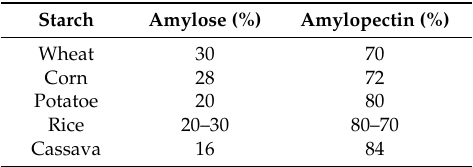
Figure 4. Amylose ( a ) and amylopectin ( b ) structures. Table 2. Amylose and amylopectin contents (%) in starch from different sources